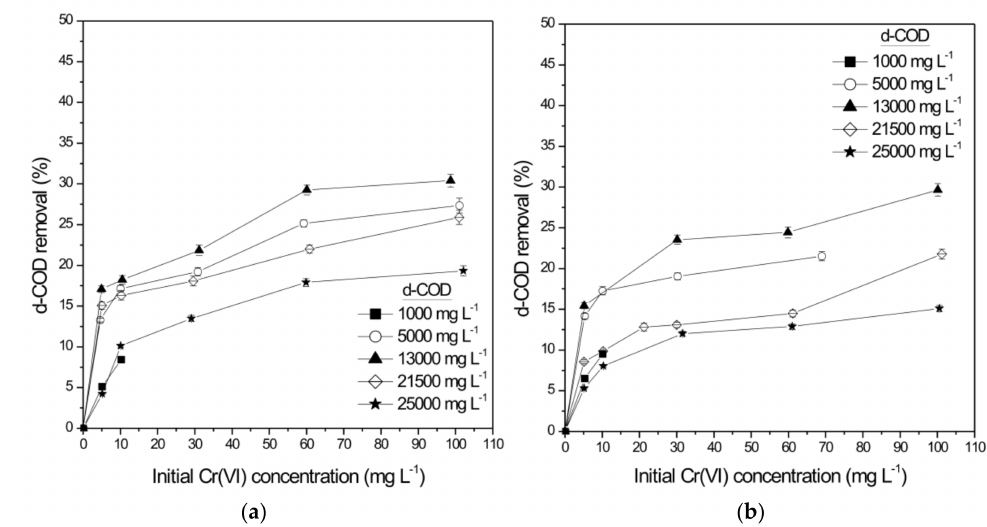
Figure 5. Percentage removal of d-COD in the Cr-WE-filter for two different recirculation rates: ( a ) 0.5 L min − 1 and ( b ) 1.0 L min − 1 .